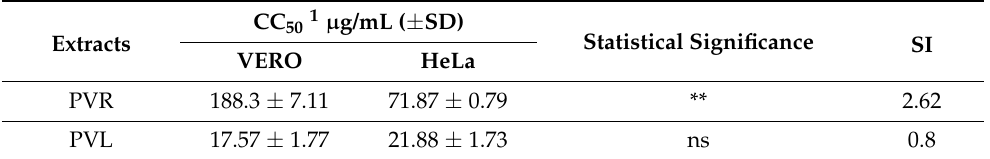
Table 2. The CC 50 ( µ g/mL) values obtained for P. vulgaris root (PVR) and leaf extracts (PVL) after 72 h incubation using the MTT-based assay.